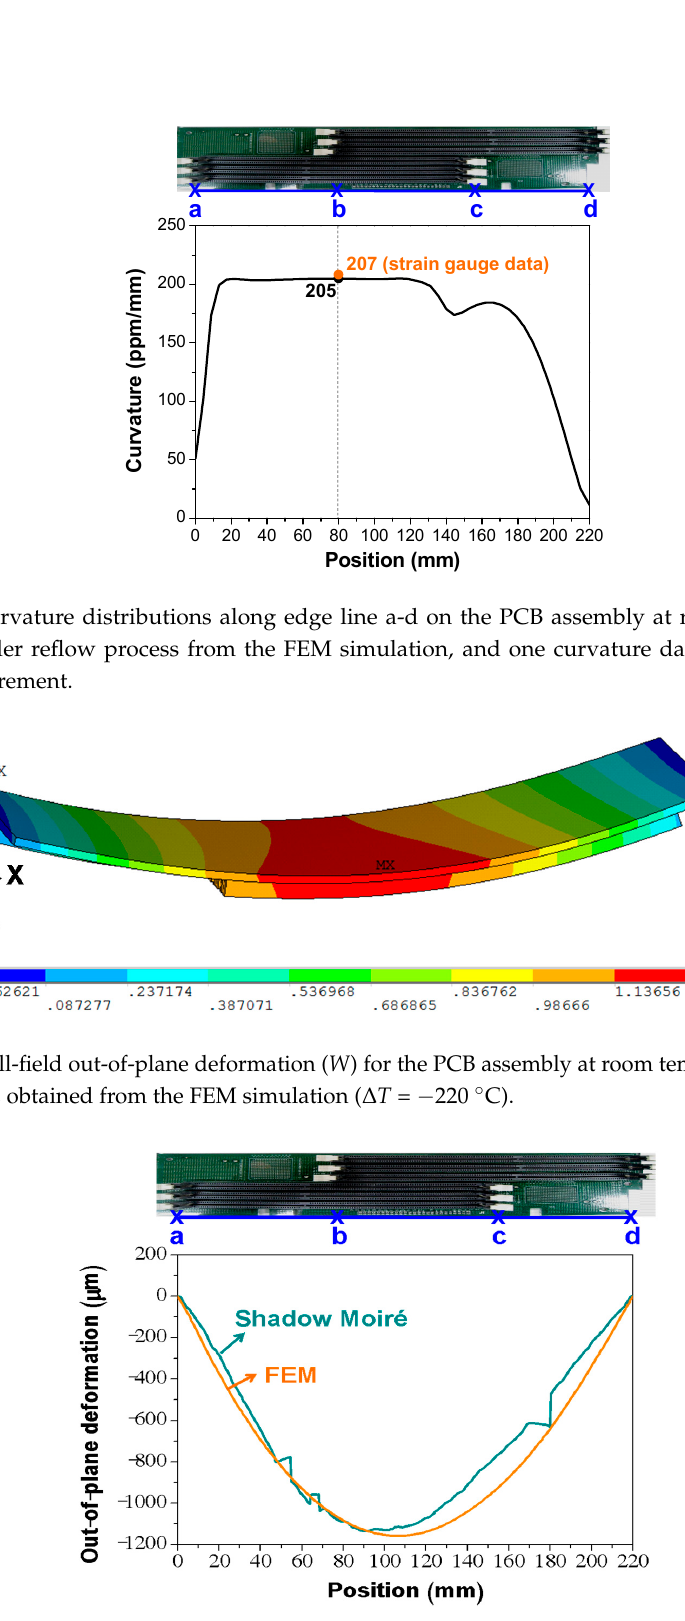
Figure 11. Comparison of out-of-plane deformation of the PCB assembly between shadow moiré experiment and FEM simulation.